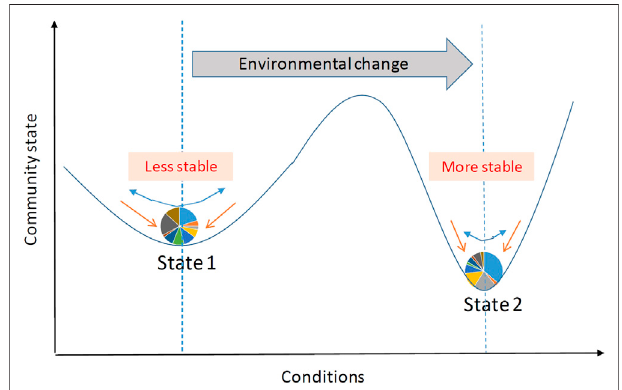
FIGURE 1 | Schematic of the evolution of microbial community states in response to external perturbation. External perturbation (blue arrows) can affect microbial community composition (shown in a pie chart), de fi ned as a community state. For each state, the ball-in-basin diagram portrays stability measured by the variance in the stationary distribution of the location of the ball. White arrows indicate the reaction of microbial community to the